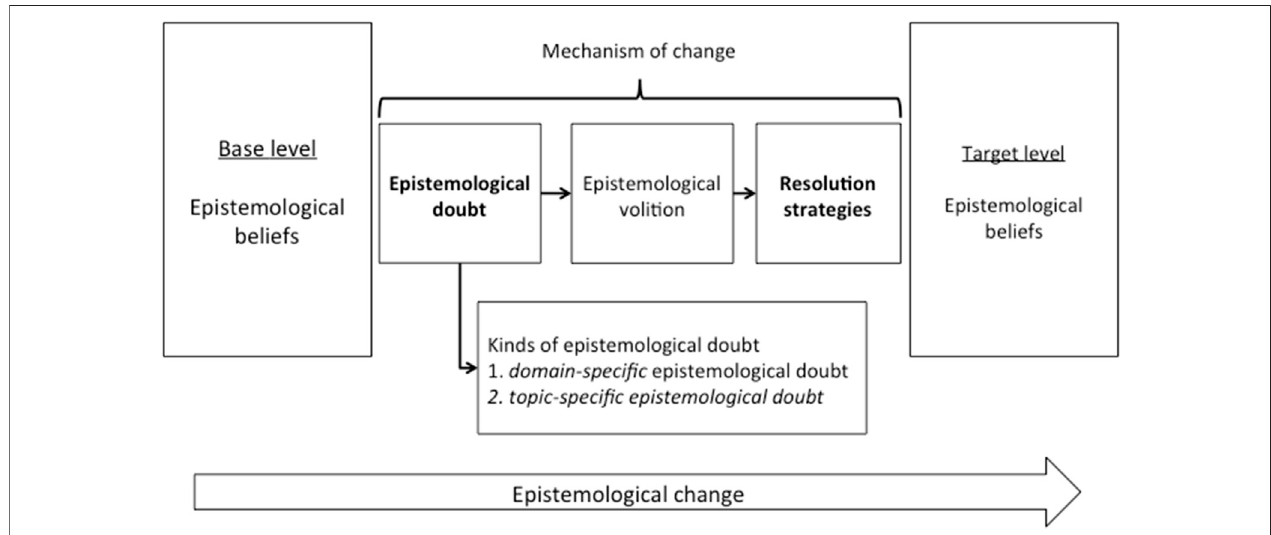
FIGURE 1 | Adapted version of Bendixen and Rule (2004) Epistemological Change Model. Terms printed in bold face refers to change mechanisms that are addressed in the